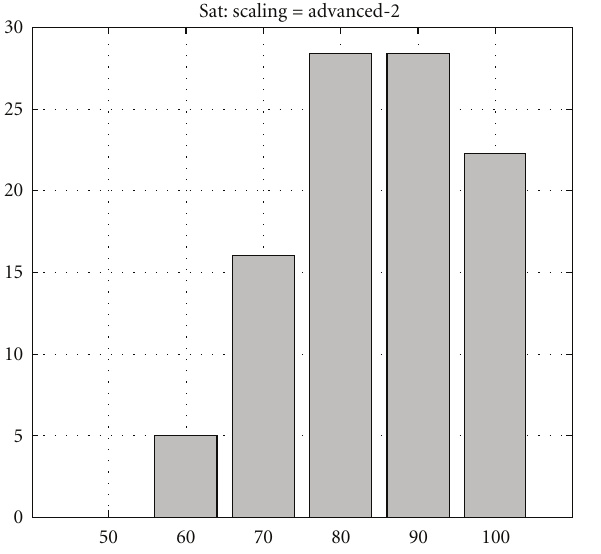
Figure 12: Satisfaction histogram for ratio-oriented scaling